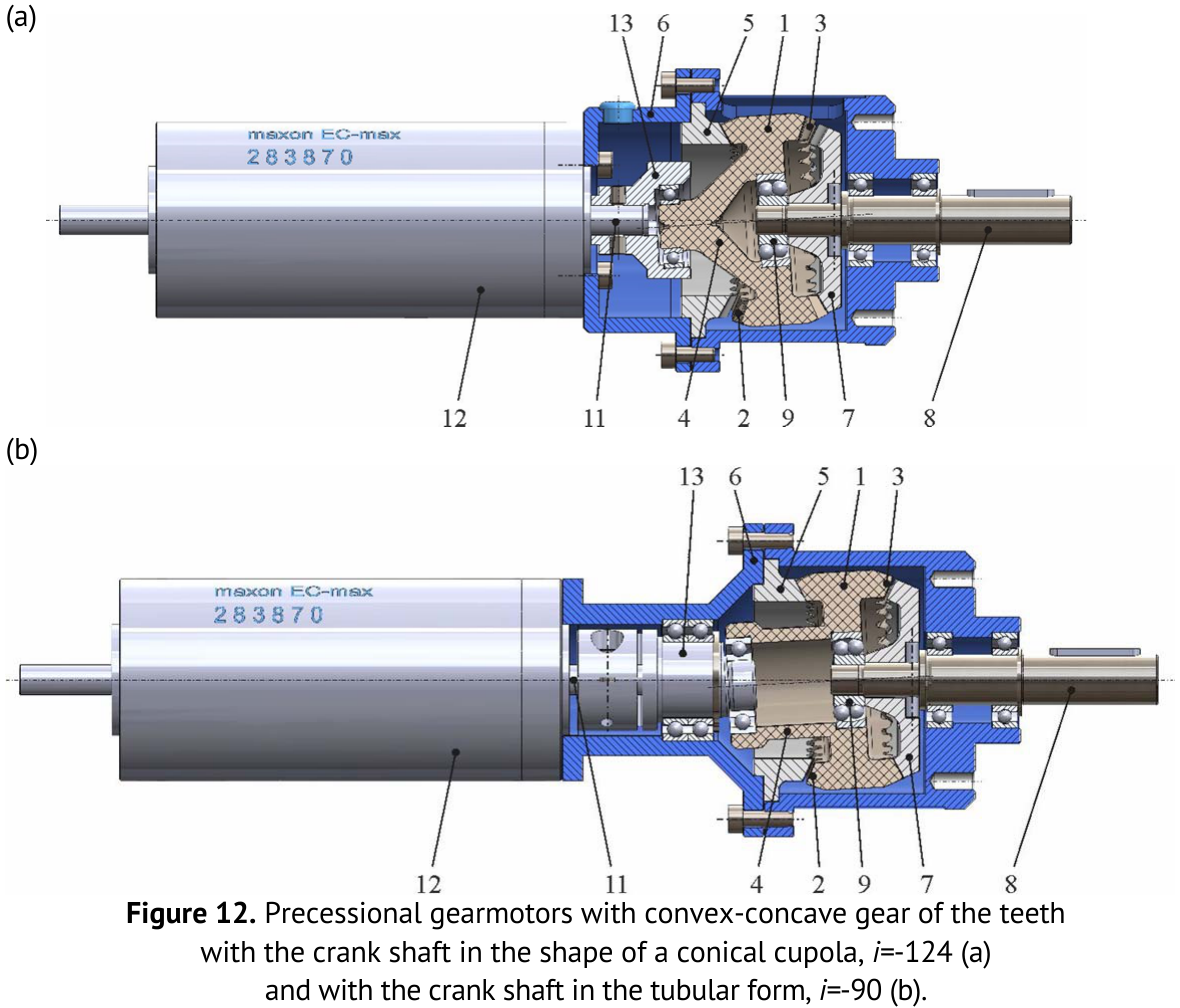
Figure 12. Precessional gearmotors with convex-concave gear of the teeth with the crank shaft in the shape of a conical cupola, i= -124 (a) and with the crank shaft in the tubular form, i= -90 (b).